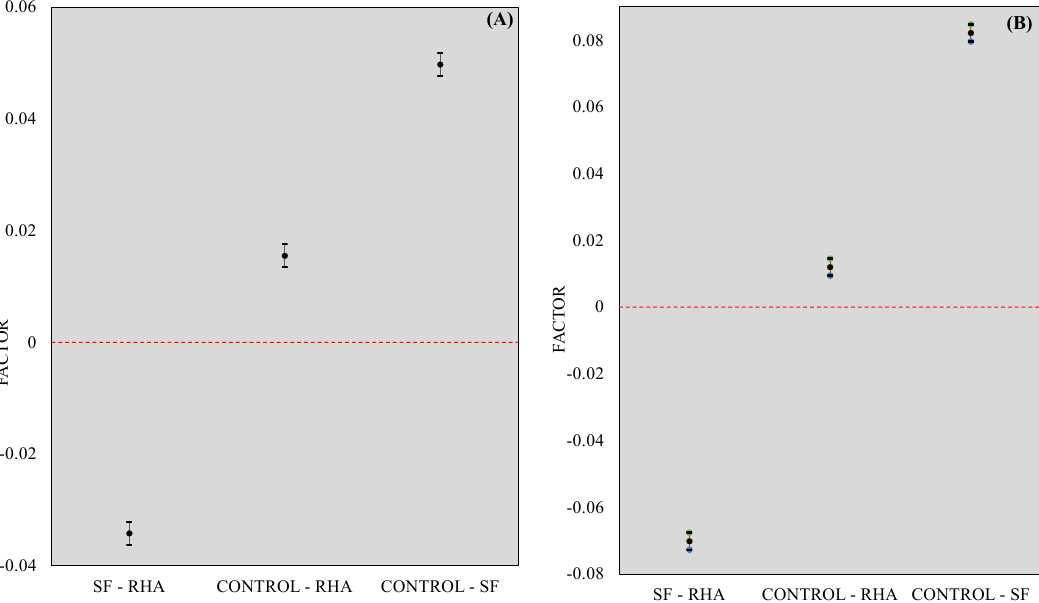
Figure 5. Comparative analysis of the averages, Tukey's test, for 14 (A) and 28 (B) days of exposure among the series studied, for a significance level of